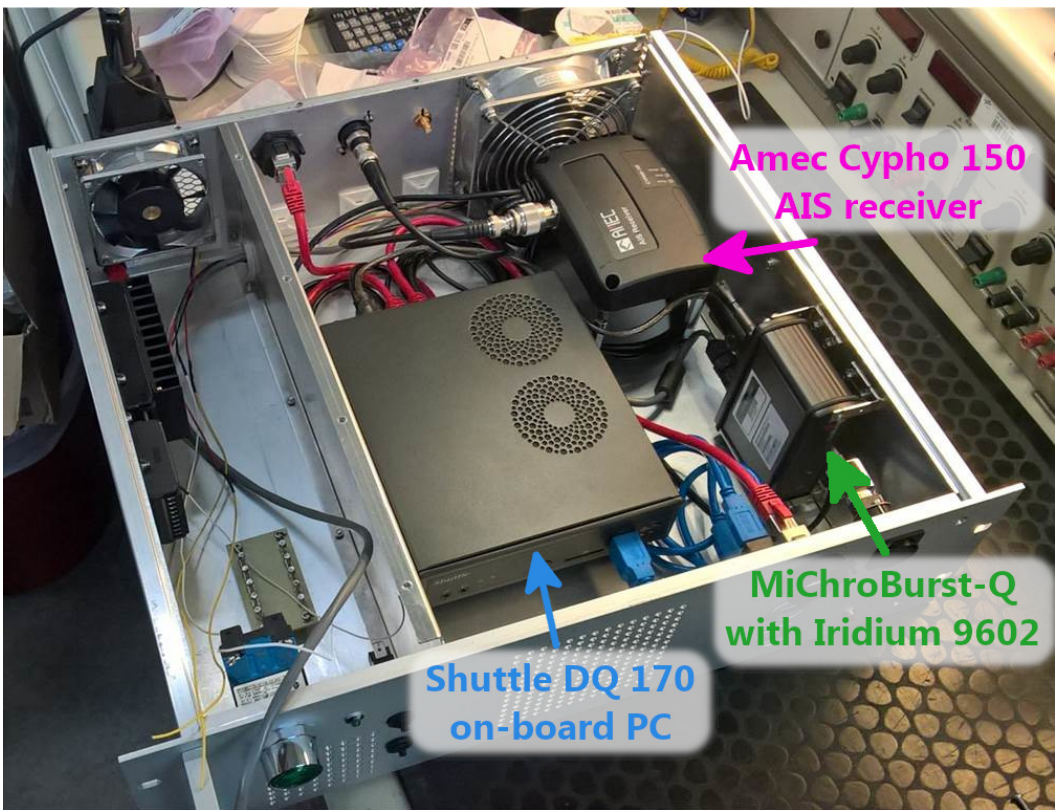
Figure 2. Autonomous Real-Time Detection of Moving Maritime Objects (AMARO)-Box with hardware components during